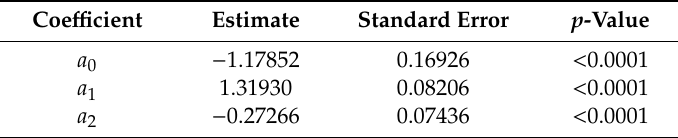
Table 2. Summary of linear regression analysis.